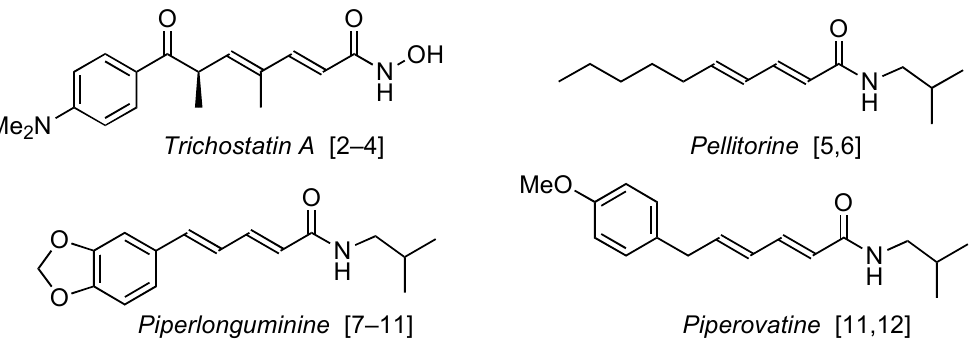
Figure 1. Examples of naturally occurring, biologically active 2,4-dienamides.